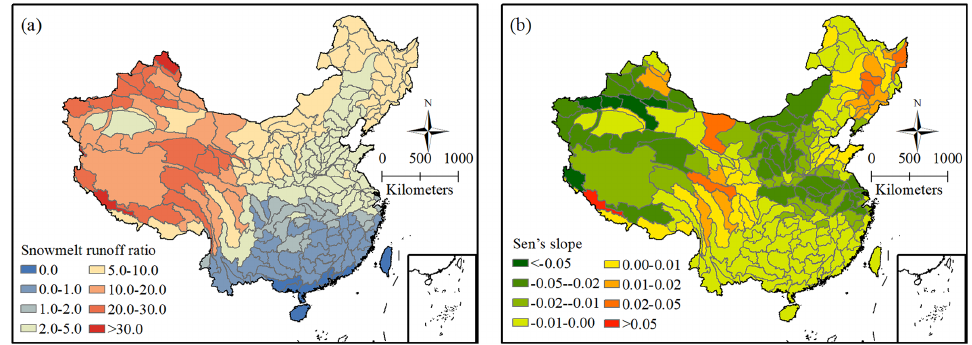
Figure 10. Spatial distribution of the mean annual snowmelt runoff ratio (percent) (a) , and Sen’s slope of the annual snowmelt runoff ratio (percent per year; hereafter %yr − 1 ) (b) in the third-level basins in China during the 1951–2017